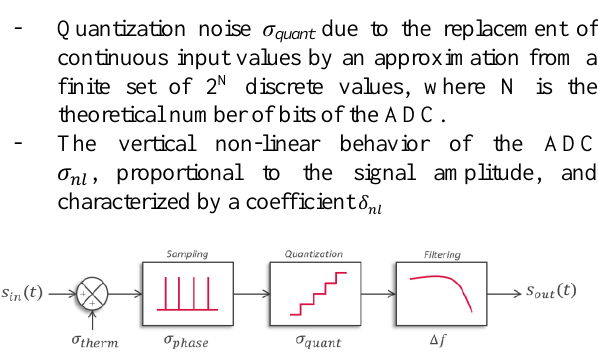
Fig. 2. Simplified model of a digitizer showing error sources during the two steps of the digitization: sampling and quantization [3].